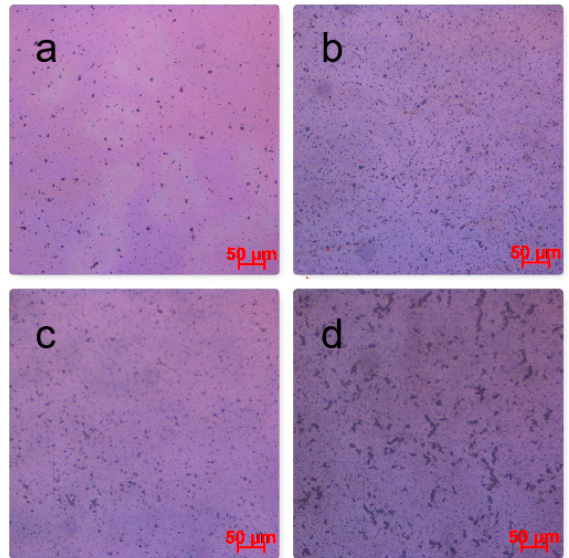
Figure 5. Micrograph of the glycerol–graphene coupling agent. ( a ) graphene mass fraction is 0.25%, ( b ) graphene mass fraction is 0.5%, ( c ) graphene mass fraction is 0.75%, ( d ) graphene mass fraction is 1%.